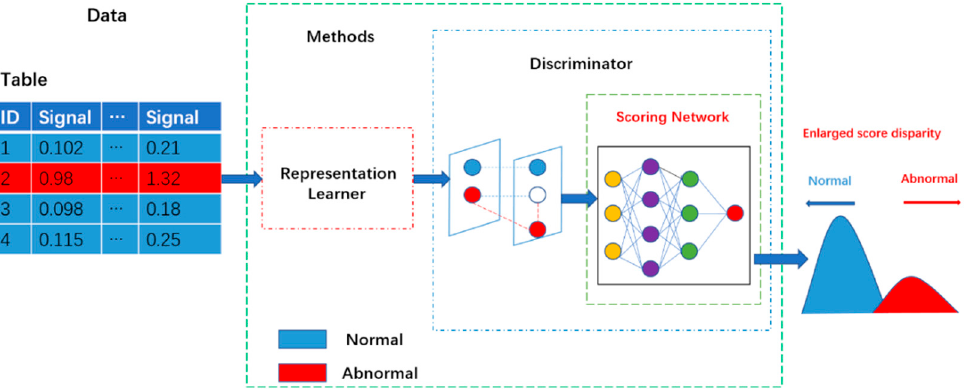
Figure 1. The basic flow of an unsupervised score-guided network. In this model, the representation learner is simultaneously trained with the scoring network. The scoring network guides the representation learner to learn better discriminative information from the input data.